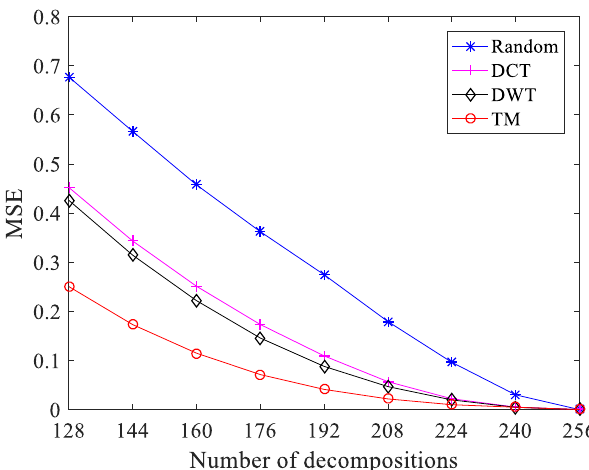
Figure 1. Comparison between the four sparsifying dictionaries under the different number of decompositions using orthogonal matching pursuit (OMP).